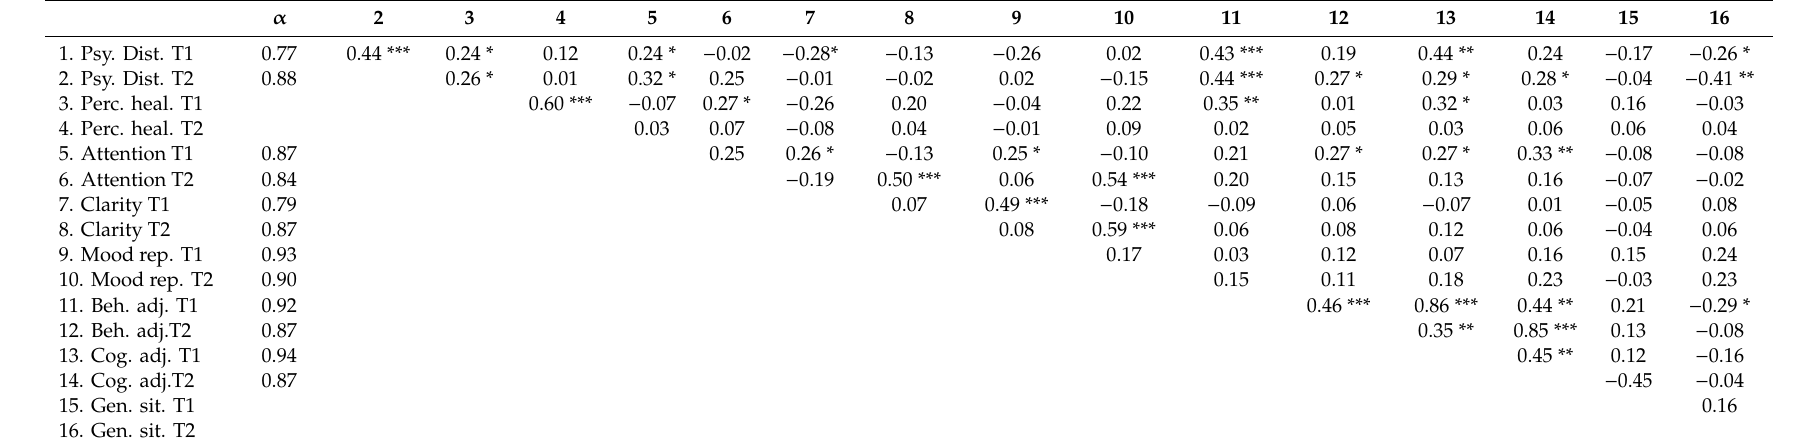
Table 1. Internal consistencies and partial correlations between perceived distress, perceived health, emotional intelligence (EI), socio-cultural adjustment and general situation across time in Ecuadorian and Romanian